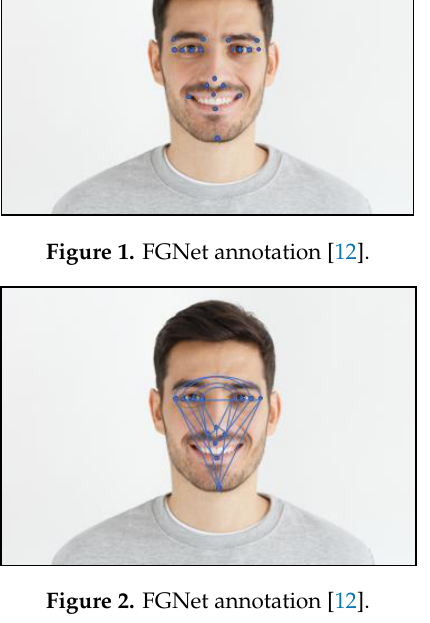
Figure 2. FGNet annotation [12].